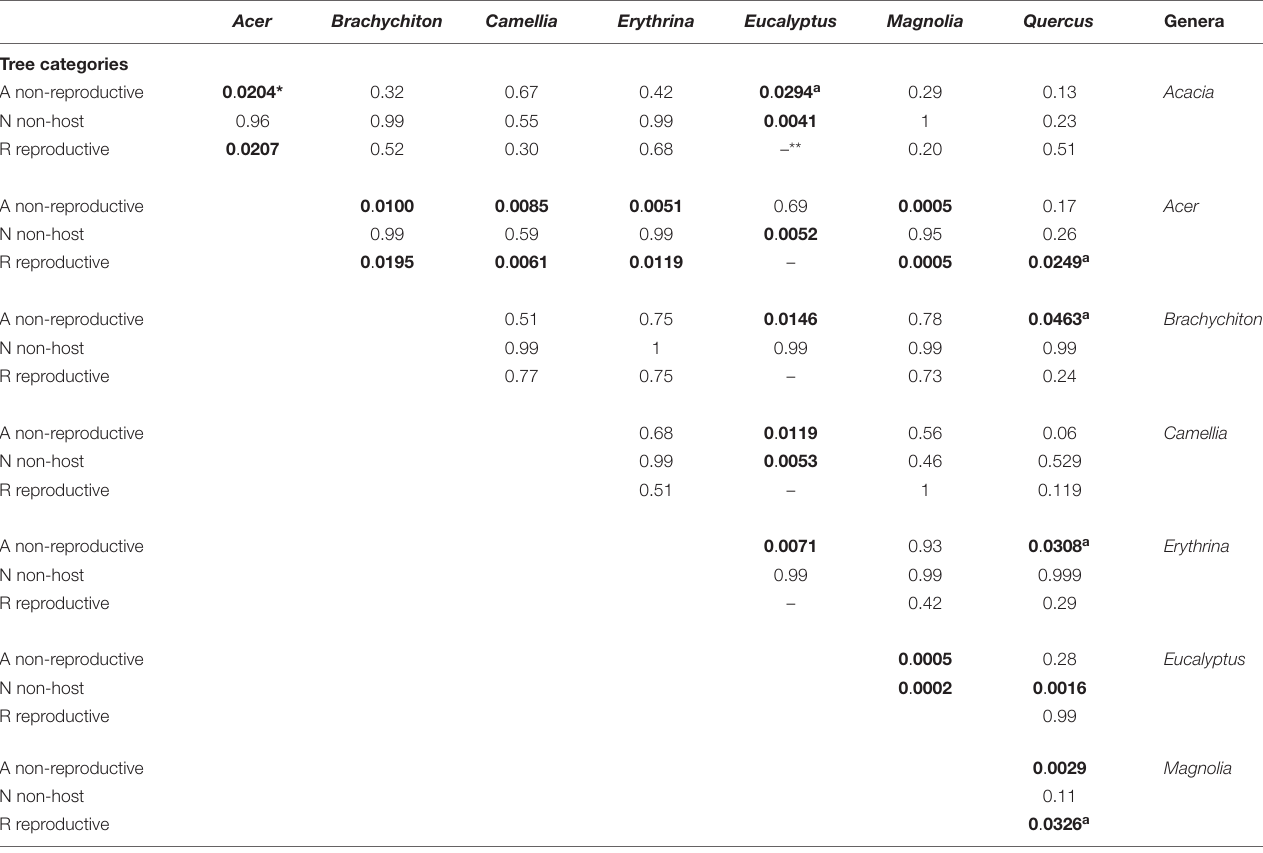
TABLE 6 | Comparison between of % tree species of each category eight botanical